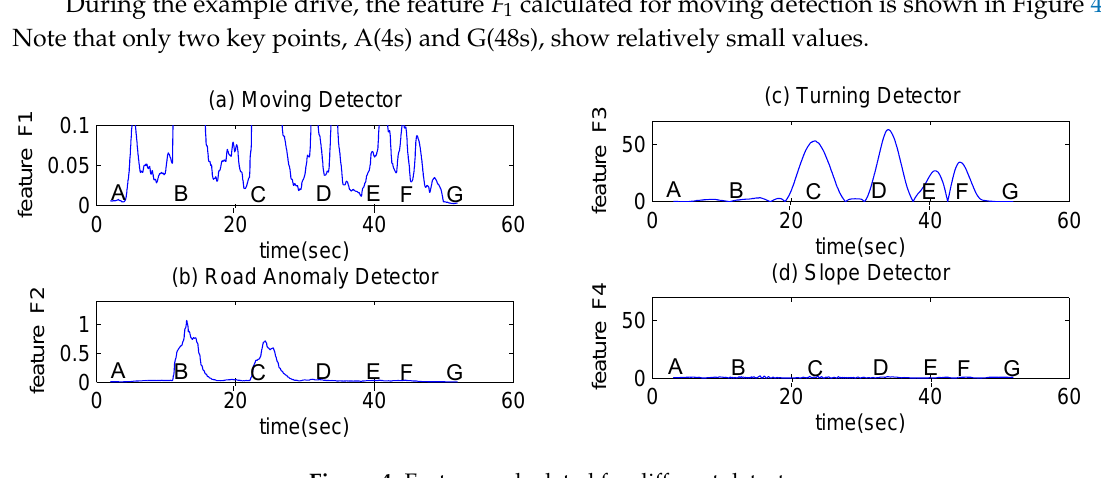
Figure 4. Features calculated for different